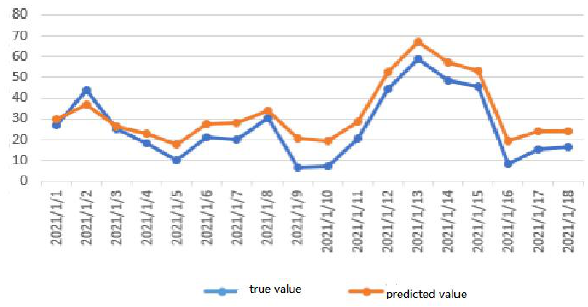
Figure 6. Beijing Dongsi Railway Station forecast value compared with the real